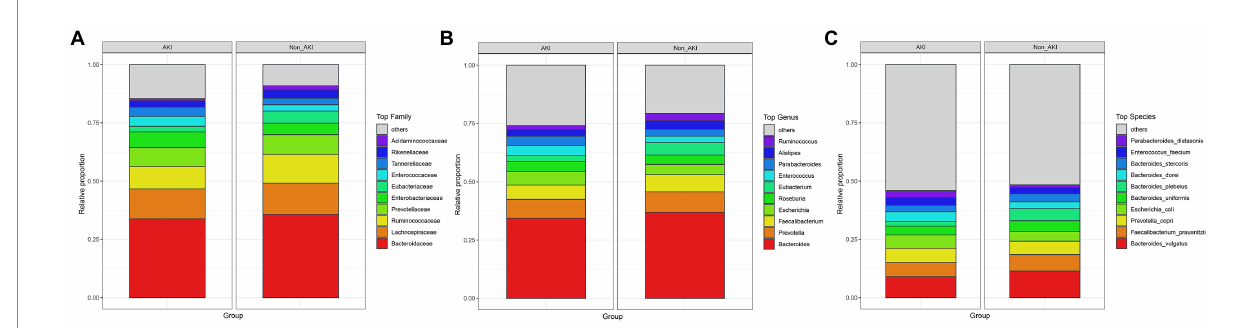
FIGURE 3 Top 10 relative abundance histograms at the family, genus, and species levels of the groups. (A) Top 10 relative abundance histograms at the family level of the groups. (B) Top 10 relative abundance histograms at the genus level of the groups. (C) Top 10 relative abundance histograms at the species level of the groups. The others represent the sums of the relative abundances of all others except the top